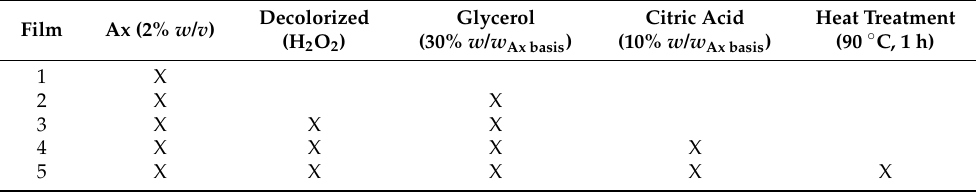
Table 1. Different conditions tested in the production of arabinoxylan (Ax) films, with decolorization process employing hydrogen peroxide, glycerol as plasticizer, citric acid as cross-linker, and heat treatment at 90 ◦